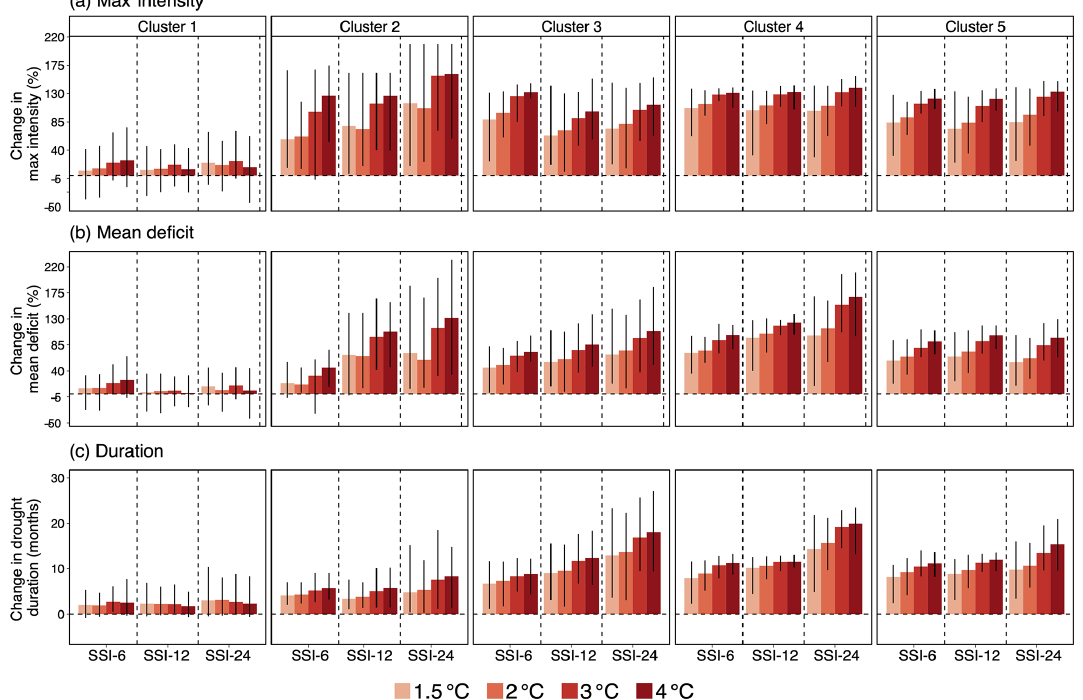
Figure 11. Mean change across the 12 UKCP18 regional projections in (a) max drought intensity (%), (b) mean drought deficit (%), and (c) drought duration (months) for the 2010–2012 drought across four warming levels for each cluster and SSI accumulation period. The error bar indicates spread across the 12 regional